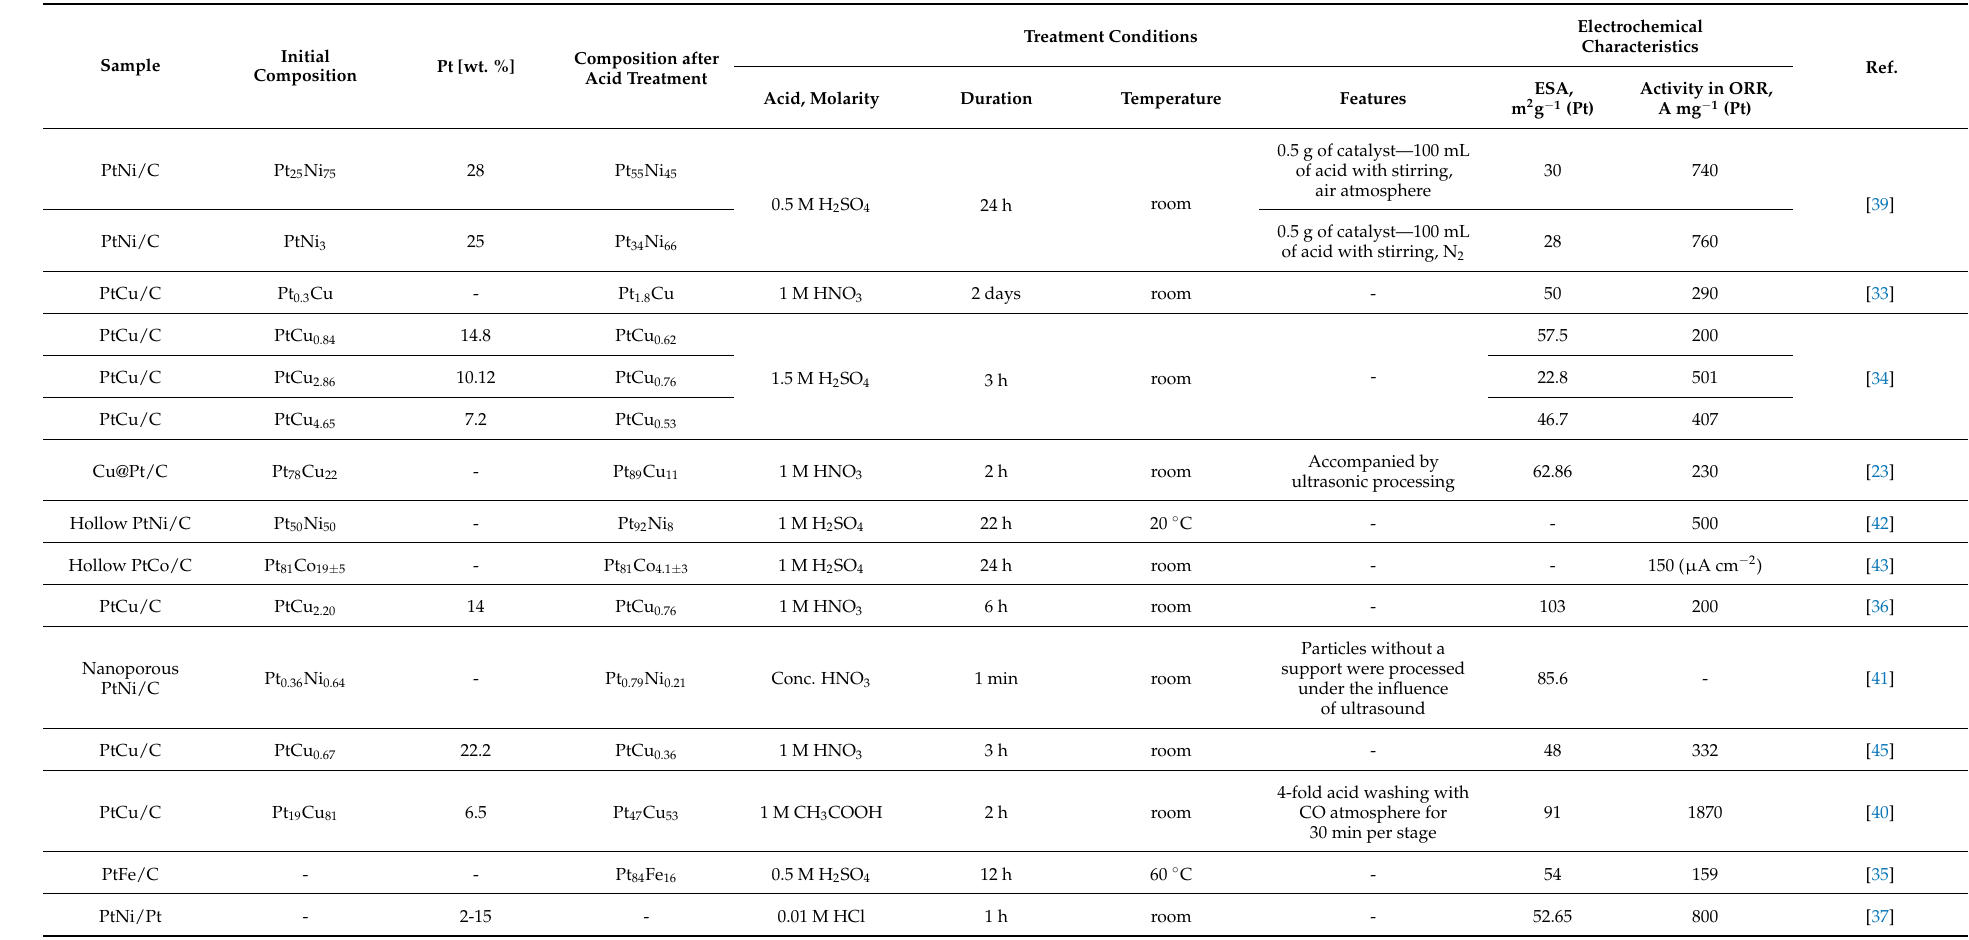
Table 1. Structural and electrochemical characteristics of acid-treated bimetallic